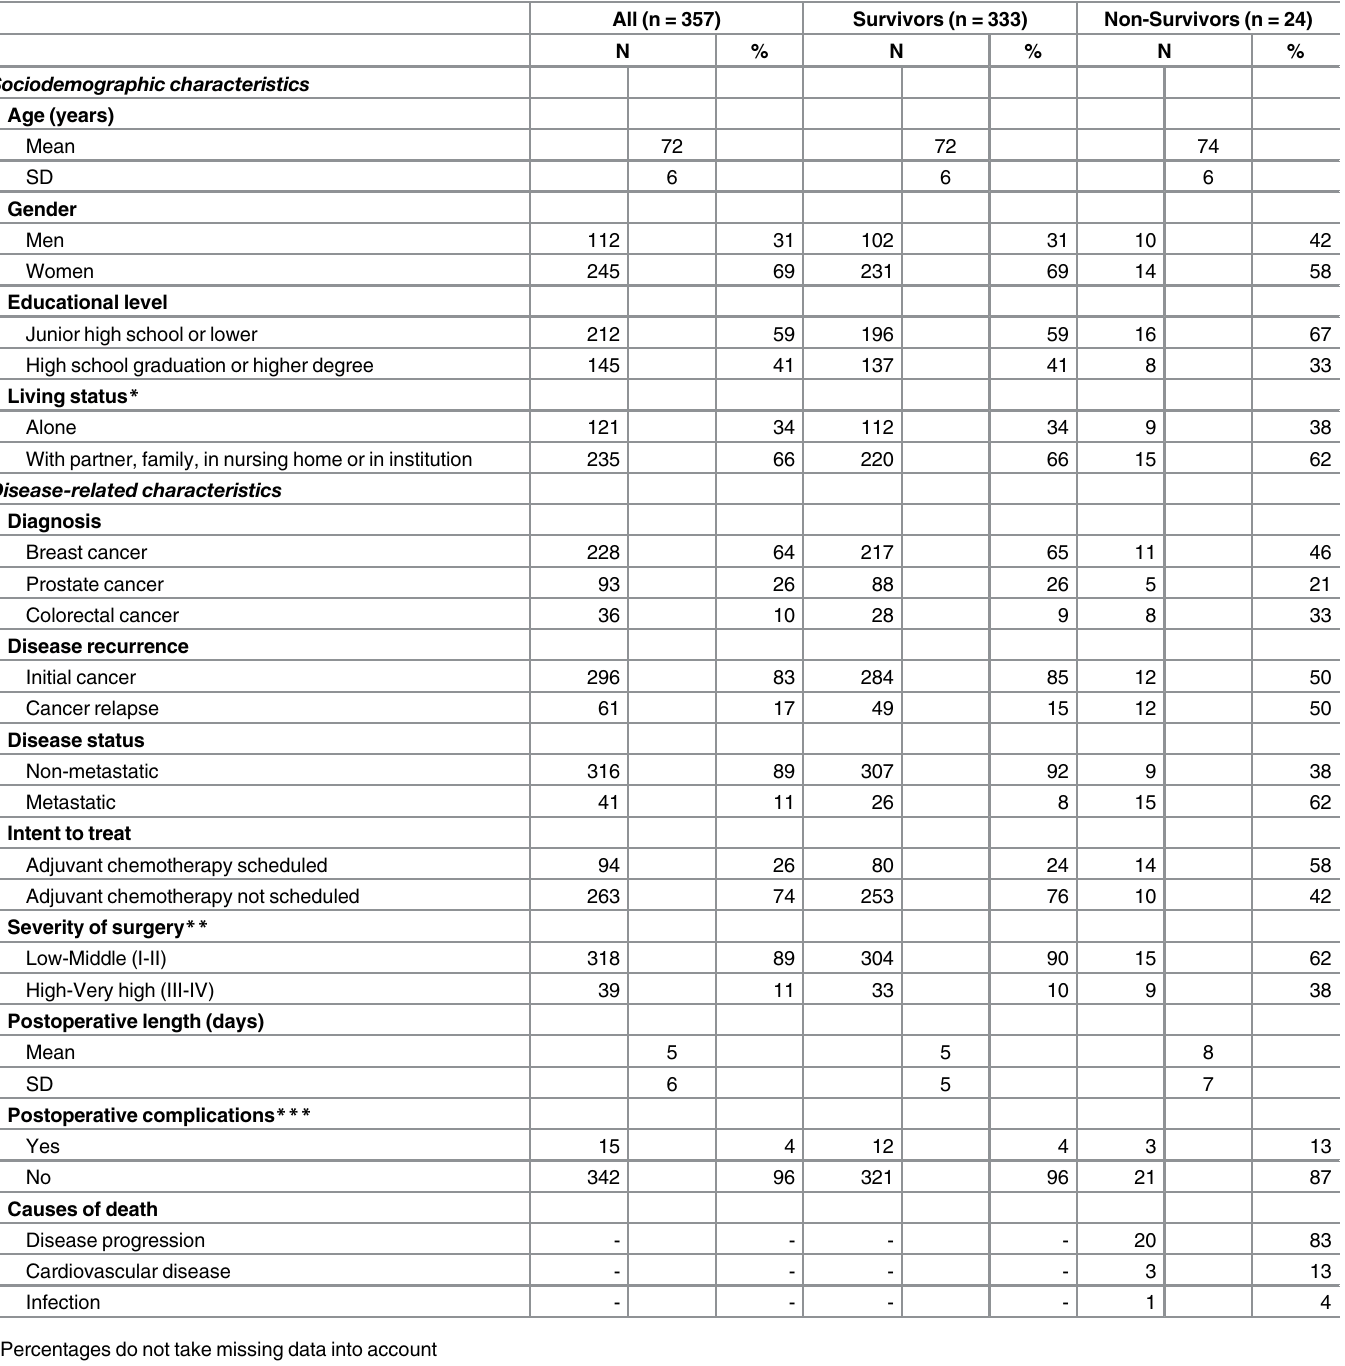
Table 1. Sociodemographic and disease-related characteristics of older patients at the time of cancer treatment initiation, stratified for Survivors/ Non-Survivors at 2 years (n = 357).